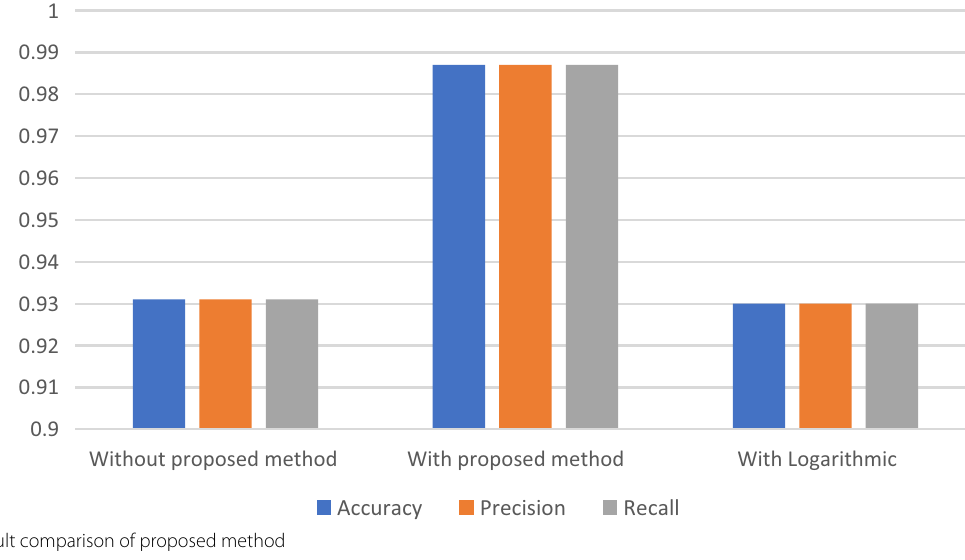
Fig. 7 Result comparison of proposed method